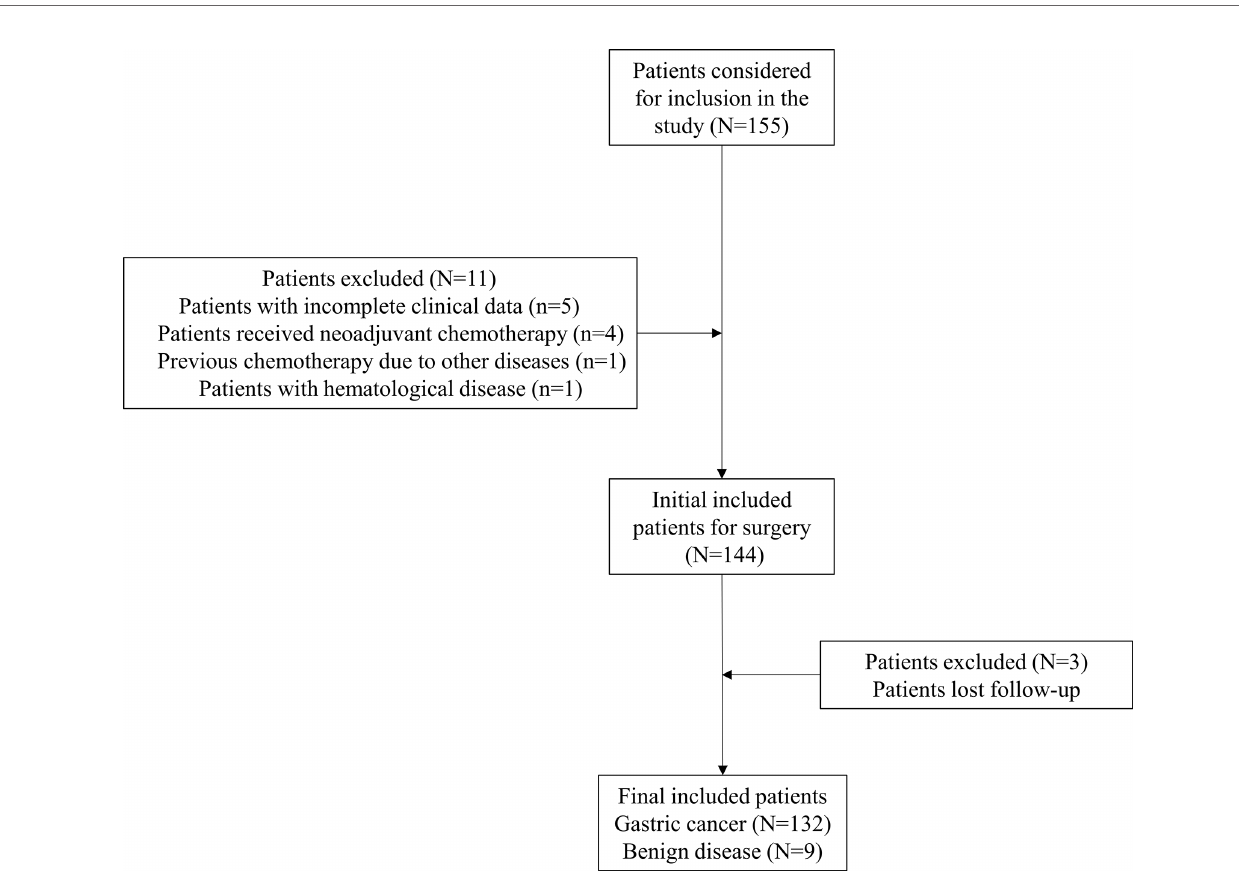
Supplementary Table 4 . Univariate Cox regression analysis